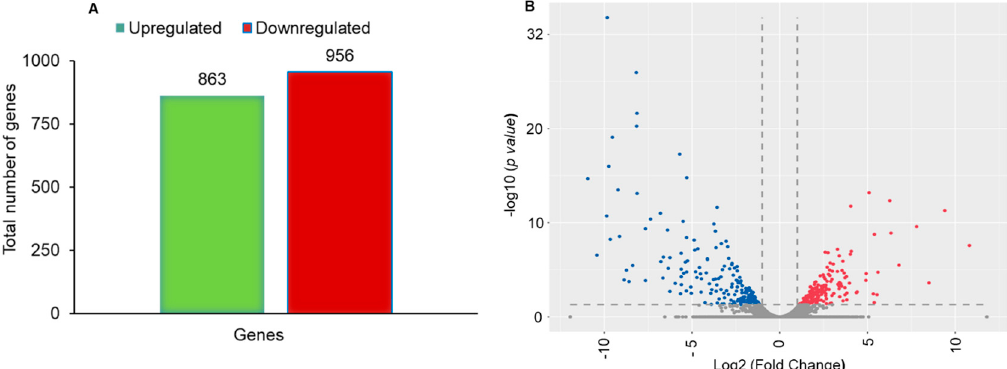
Figure 2. De novo transcriptome analysis of unselected and Noposion Yihaogong ® 5% EC insecticide-exposed larvae. ( A ) Bar graph showing total number of up- and down-regulated differentially expressed genes (DEGs). ( B ) Volcano plot analysis of differentially regulated genes in untreated and Noposion Yihaogong ® 5% EC insecticide-exposed sample. DeSeq was used for determining upregulation and downregulation of genes based upon relative Fragments Per Kilobase Million (FPKM) counts ( x -axis: log2fold change; y -axis: − log ( p -value)).